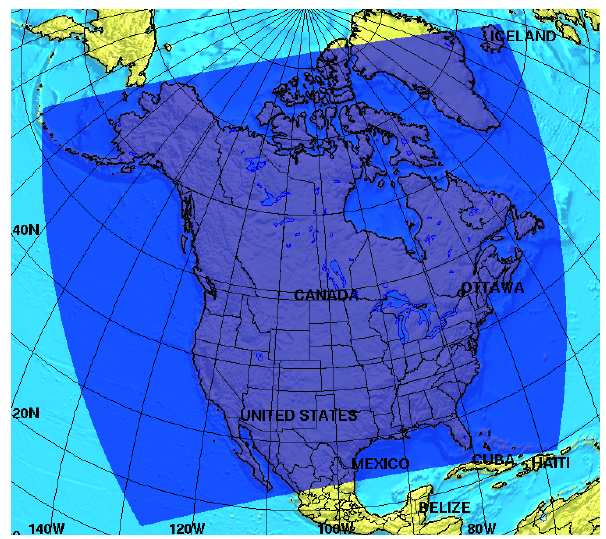
Figure 3. GEM-MACH model North American domain, with 10km × 10km horizontal grid